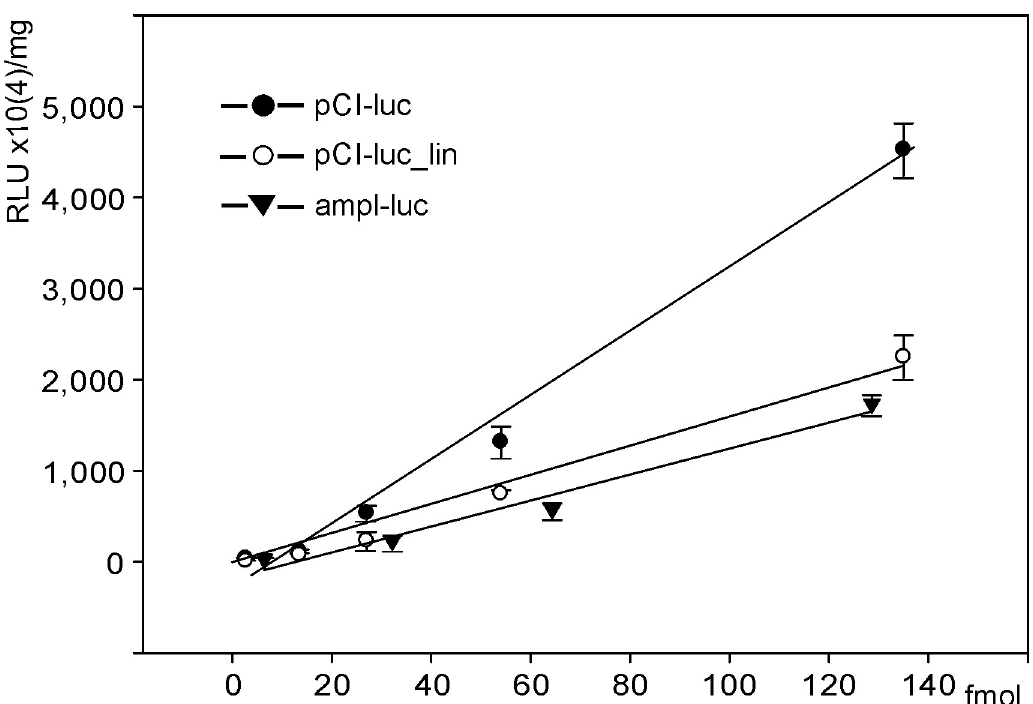
Fig 2. Luciferase activity in HEK293 cells transfected with pCI-luc, pCI-luc_lin, or ampl-luc. Abscissa: DNA quantities (femtomoles) of expression vectors pCI-luc, pCI-luc_lin, and ampl-luc used in transfection. Ordinate: luciferase activity normalized to protein quantity in lysates of HEK293 cells. The found relationships are described by linear equations y = (35.022x - 318) × 10 4 with the approximation reliability R 2 = 0.9887 for pCI-luc; y = (17.514x - 148.92) × 10 4 with R 2 = 0.9928 for pCI- luc_lin; and y = (14.252x - 181.65) × 10 4 with R 2 = 0.9723 for ampl-luc. Luciferase activity provided by the constructed vectors was compared using the one-way ANOVA with Tukey’s correction for multiple comparisons. Significant differences in luciferase activity were observed for the pCI-luc vs pCI-luc_lin and the pCI-luc vs ampl-luc groups when the vector quantity exceeded 27 fmol. RLU, relative luminescence unit.